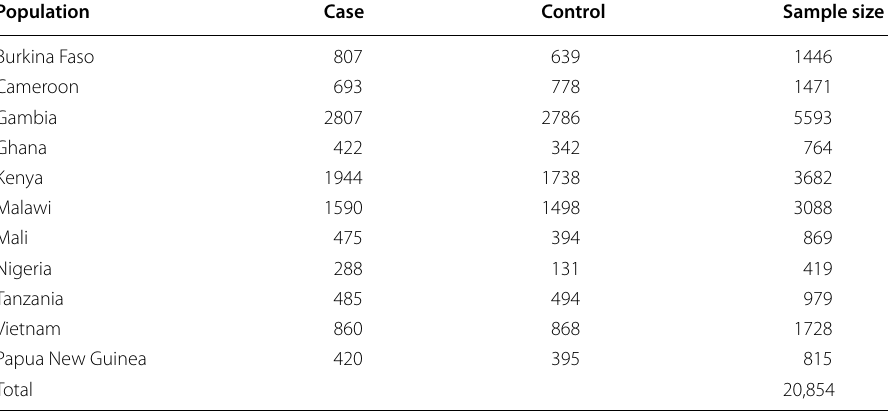
Sample size indicates the total number of individuals for each population